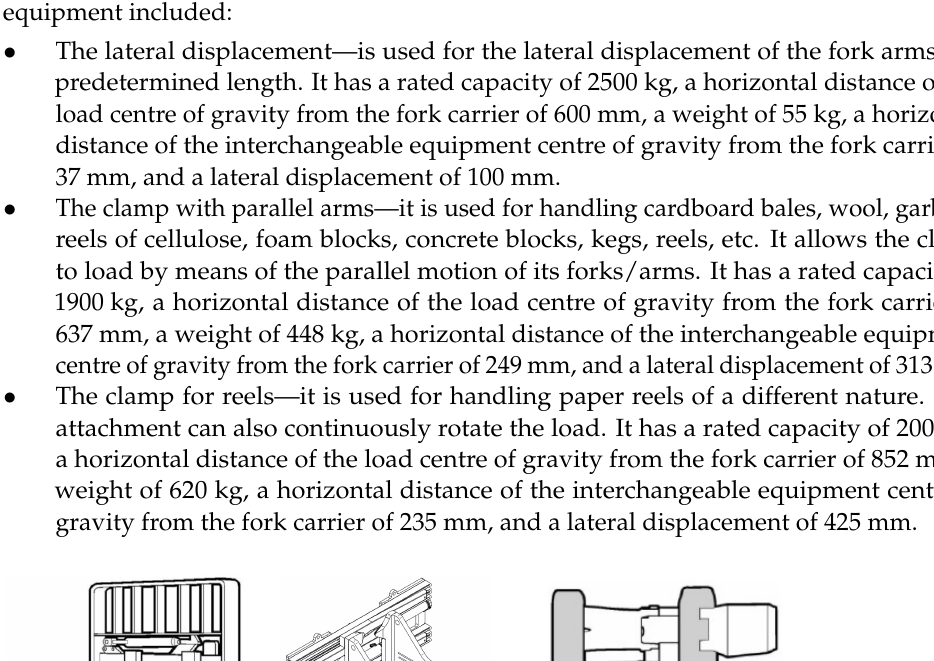
−3.2 Table 2. Comparison between experimental tests and analytical procedure for clamp with parallel arms. FLT +2.2 Table 3. Comparison between experimental tests and analytical procedure for clamp for reels. FLT